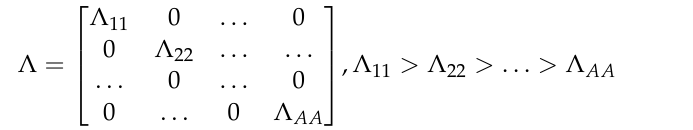
Figure 2. Radar echo preprocessing process.